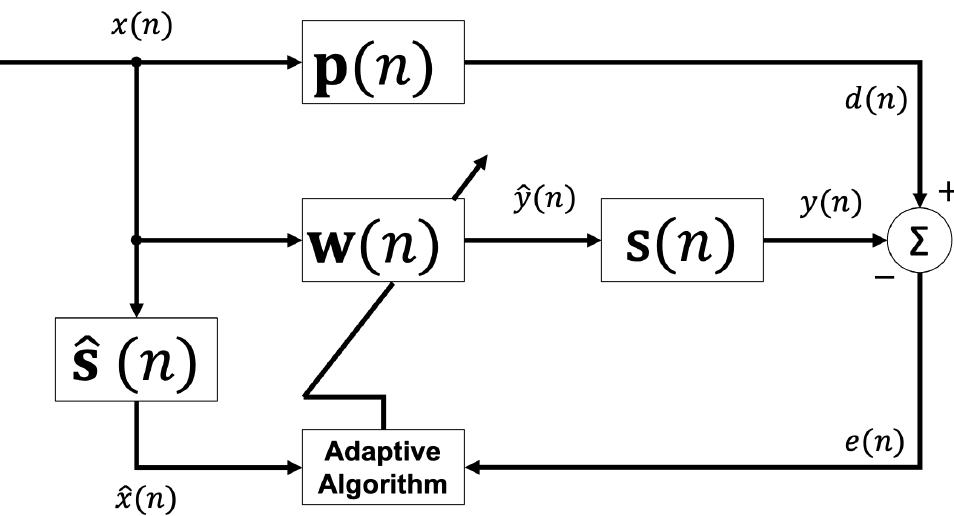
Figure 1. General scheme of the filtered-x ANC